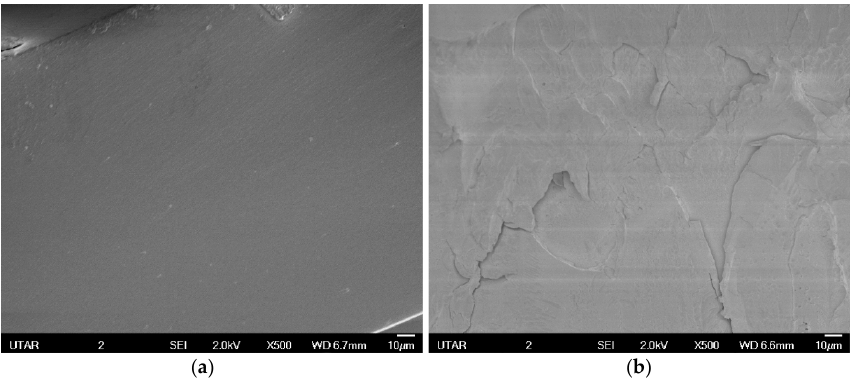
Figure 10. Tensile fracture surfaces of neat PMMA prepared by different methods. ( a ) In situ polymerization; ( b ) solution blending.